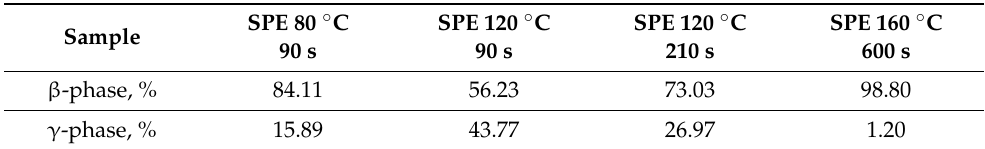
Table 1. Relative percentage of γ - and β -phases in sample considering number of electroactive phases consisting only of γ - and β -phases (100%).